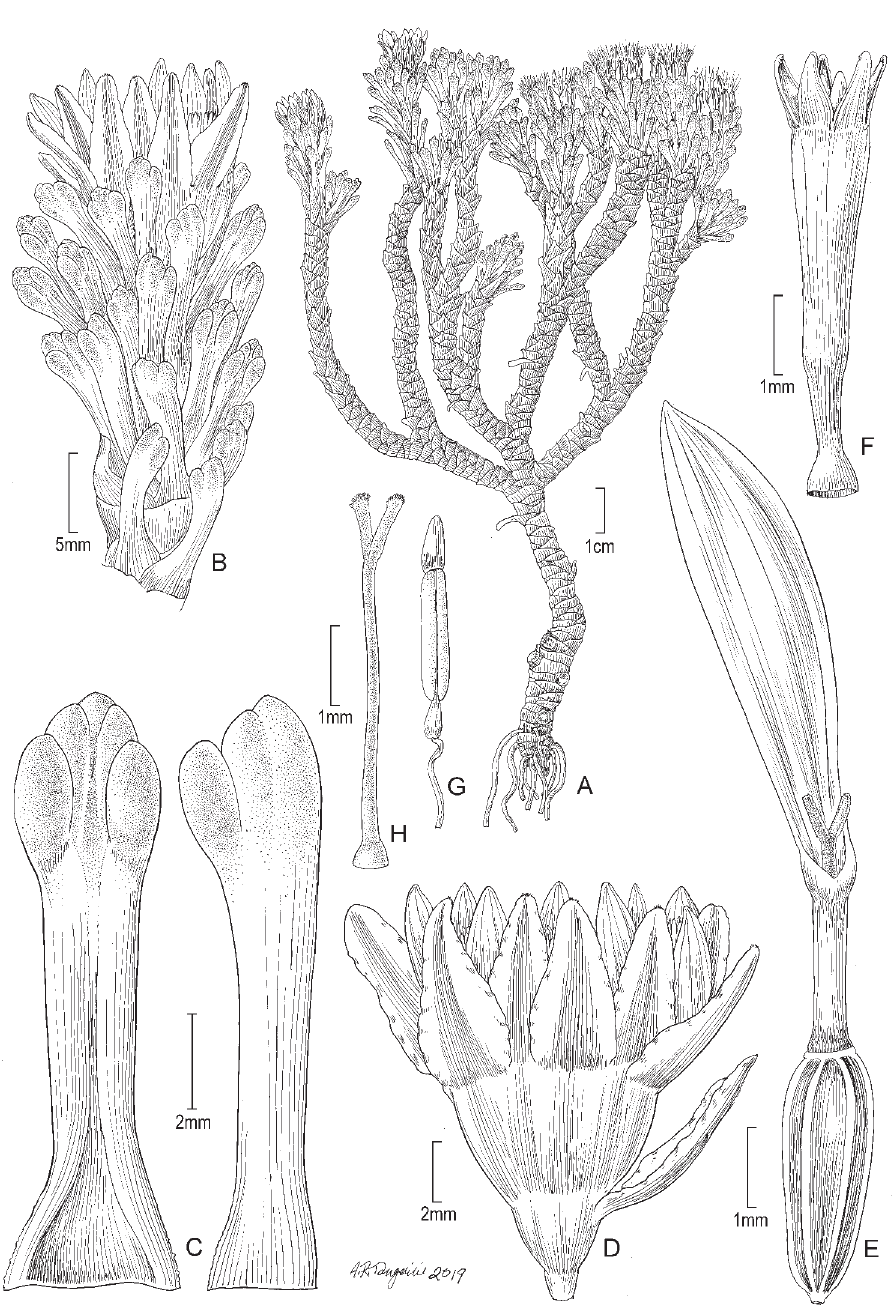
Figure 4. Xenophyllum lorochaqui A habit B stem apical part with capitulum C adaxial leaf surface (left hand) and vertical leaf profile (right hand) D capitulum E ray floret with achene (pappus removed and not drawn) F disc floret without pappus and achene G stamen H style. A, B drawn from Díaz s.n. (GH) and C–H from Castellanos s.n. (BA). Illustration by Alice